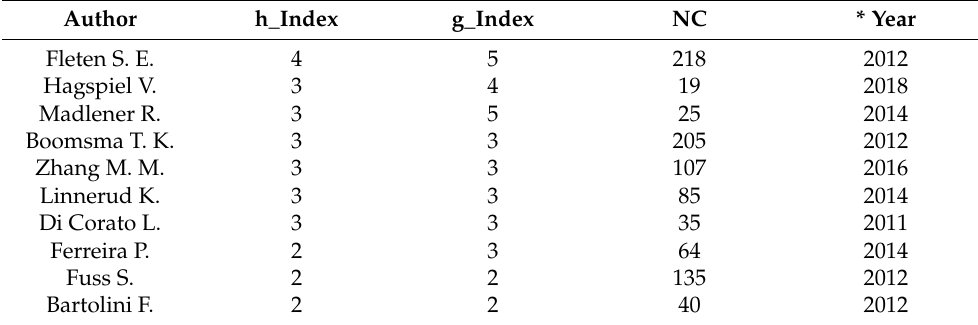
Table 12. Authors Impact (ROA).